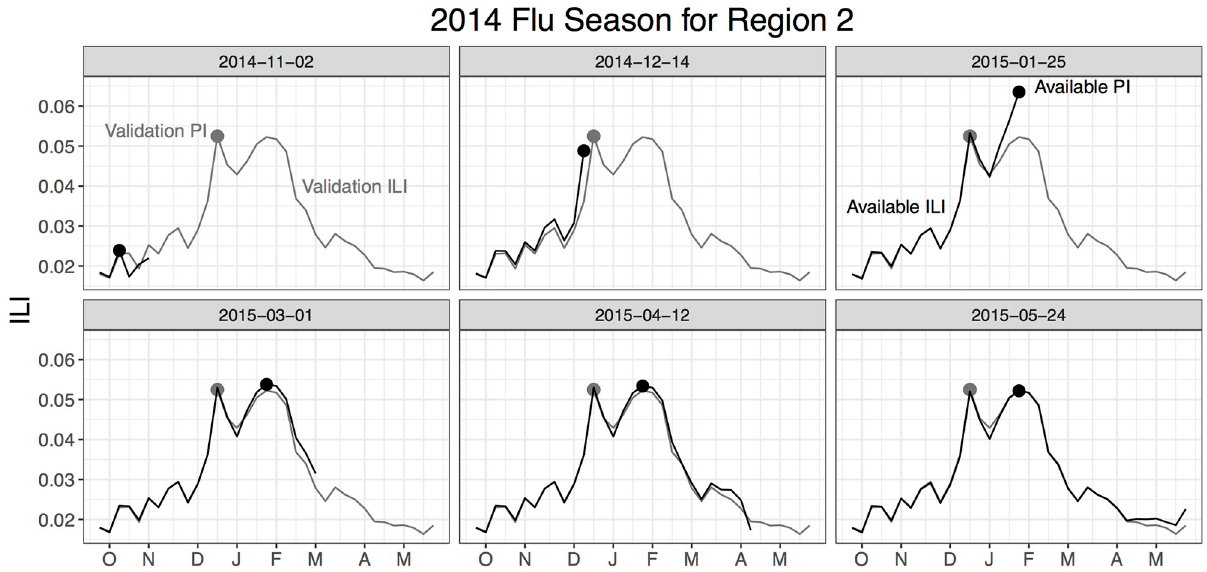
Fig 3. Backfill for the 2014 flu season for Region 2. The validation peak intensity is 0.0525 and occurs in the middle of December. The peak intensity based on ILI issued on May 24th, 2015 is 0.0522 and occurs at the end of January, a difference of 6 weeks even though the intensity of the two weeks changed only by 0.0003.